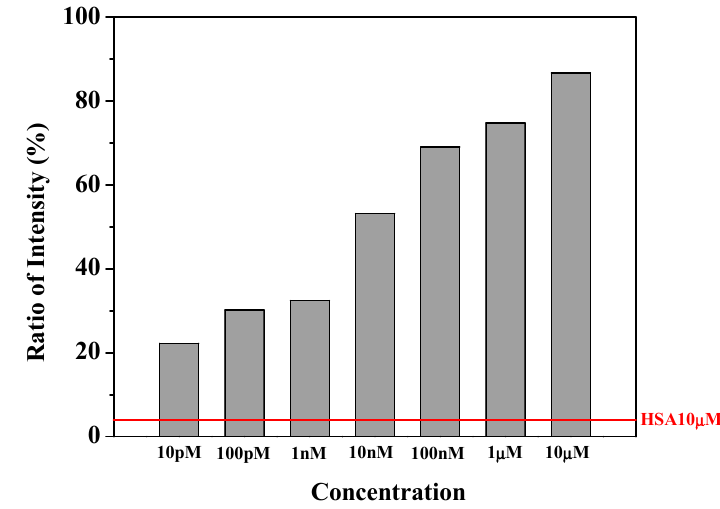
Figure 7. Graph representing fluorescence intensity in relation to concentration of targets of thrombin and human serum albumin (HSA).